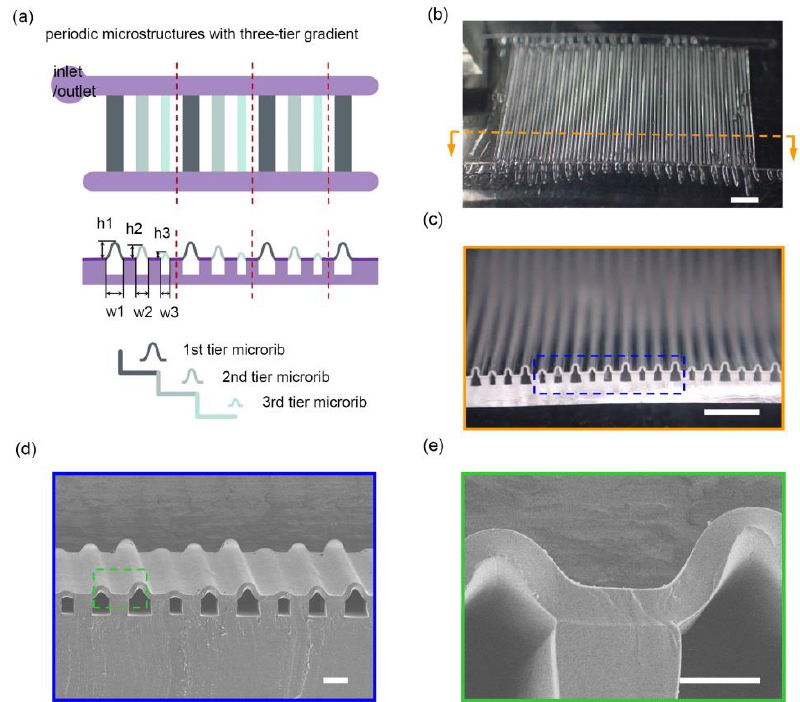
Figure 2. ( a ) Concept of the three-tier gradient. ( b ) Top-view and ( c ) side-view photographs of the fabricated surface. ( d , e ) SEM images of ( d ) the periodic gradient microstructures and ( e ) the bonding region. Scale bars: ( b ) 2 mm, ( c ) 1 mm, ( d ) 200 µ m, and ( e ) 100 µ m.